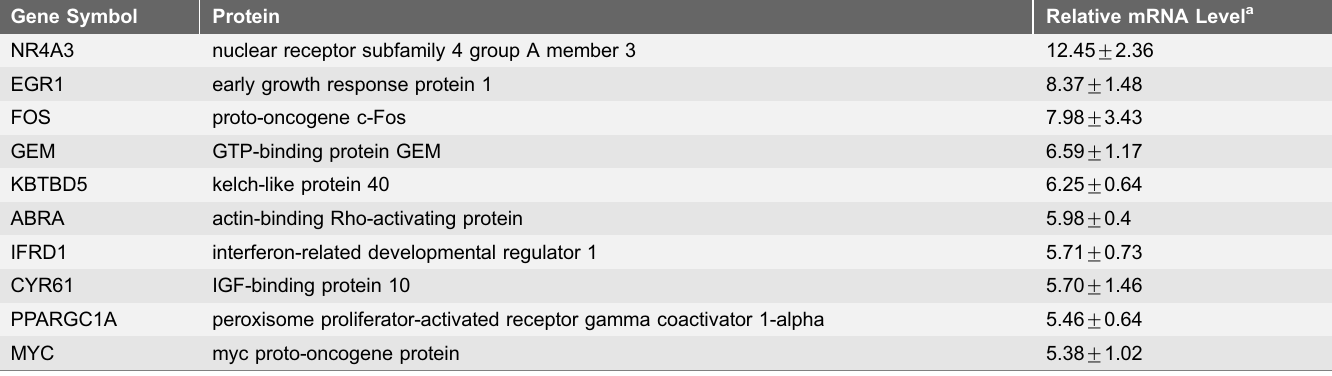
Table 1. Top 10 Expressed mRNA Gene Transcripts Following an Acute Dose of Electrical Muscle Stimulation.